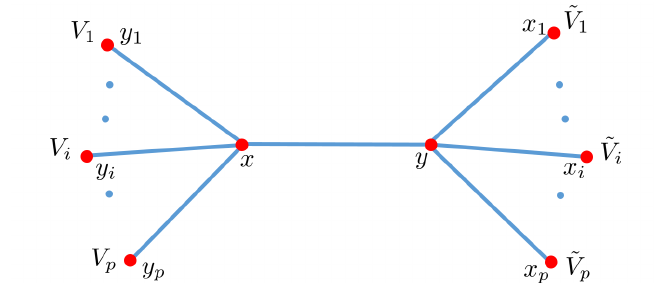
Figure 4 . The edge xy is connected with { xy i } and { x i y } . When one is restricted within this part, ˜ { V a } and { V a } encode all the information i i